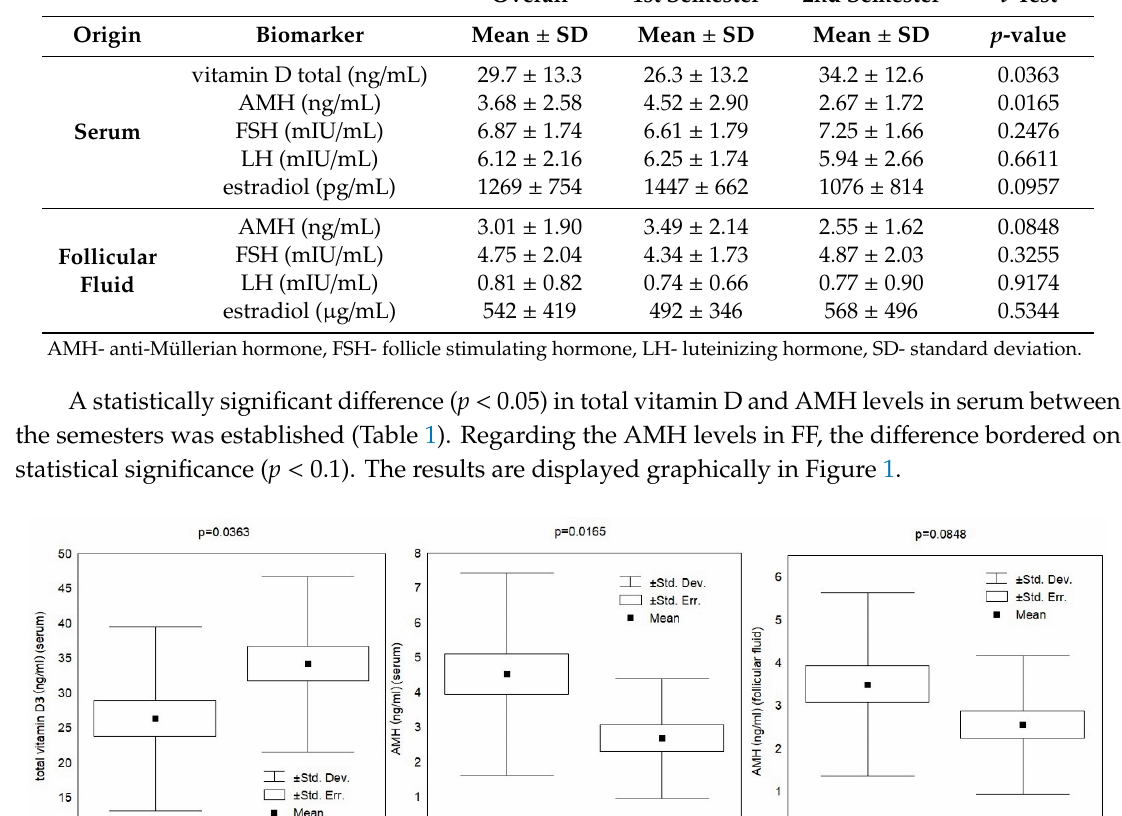
Table 1. Seasonal differences in vitamin D (total) and other biomarkers.